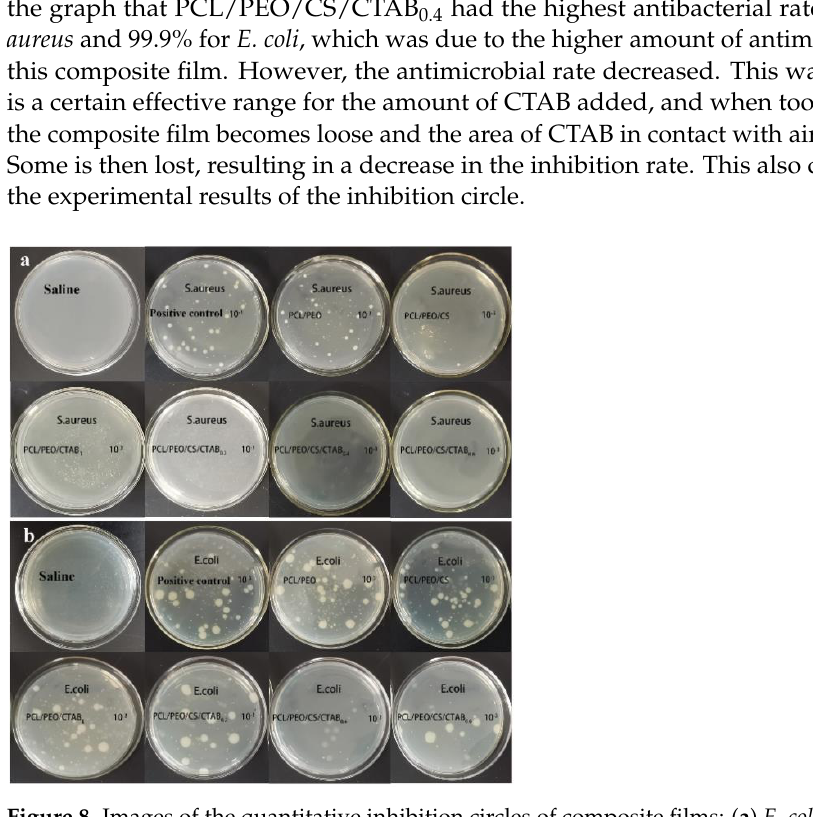
Figure 9. Images of the antibacterial rate of composite spinning films. From Figure 10A, we can see that the absorbance of the bacterial growth curve of PCL/PEO was higher than the growth curve of pure S. aureus . Since this composite spin- ning film has a fiber structure that hides bacteria more easily and PCL/PEO does not have antimicrobial components and has no antimicrobial properties, the self-borne bacteria of the sample could not be completely eliminated by UV light irradiation alone, so when incubated in the shaker, the growth curves of PCL/PEO/CTAB 1 and PCL/PEO/CS/CTAB 0.6 were higher than the bacterial growth curves in the first eight hours. The macroscopic shapes prepared from these two samples were fluffy and easily harbored bacteria, so they